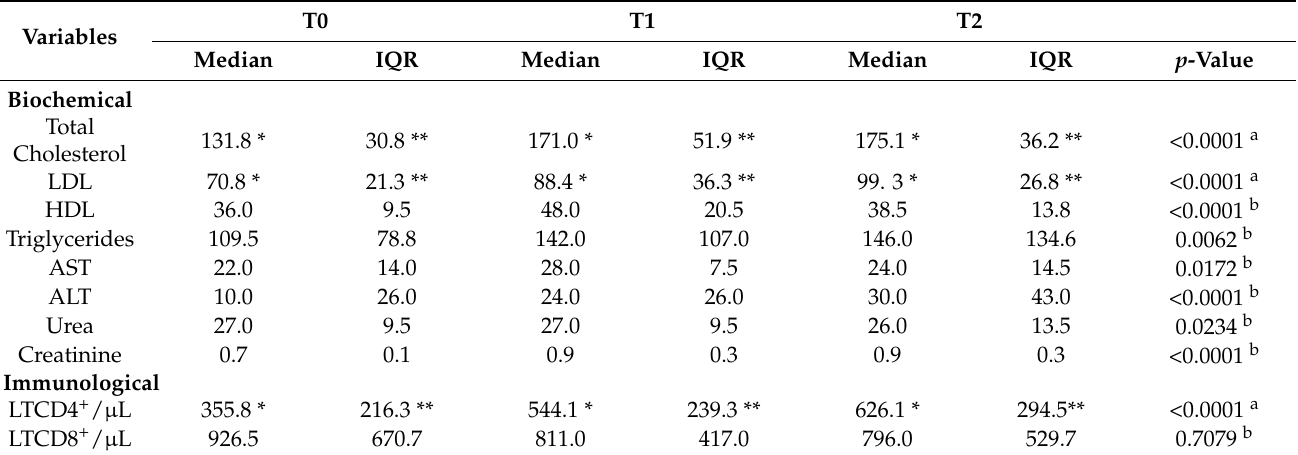
Table 2. Comparison of biochemical and immunological markers of PLHIV between the periods evaluated.